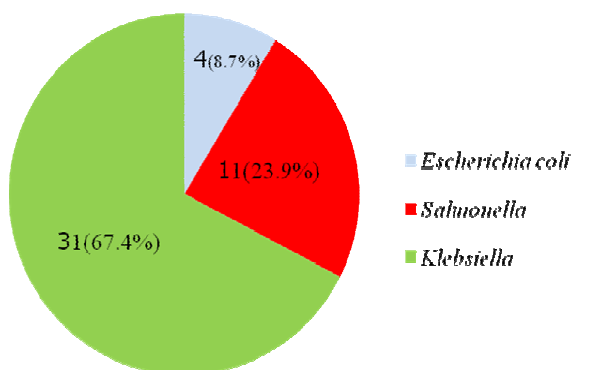
Fig. 4. Antibiogram of extended-spectrum ß-lactam isolates from pigs